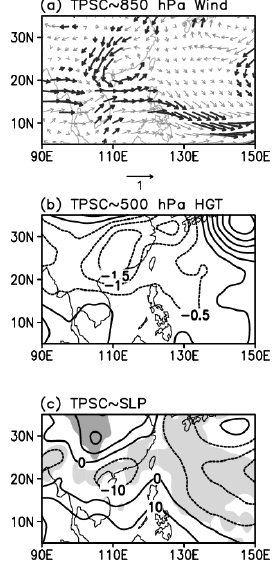
Plateau for (a) 850 hPa wind (m s −1 ), (b) 500 hPa geopotential height (gpm) and (c) sea surface pressure (hPa) in the period 1979–2012.Values exceeding the 95% confidence level are bold wind vectors or